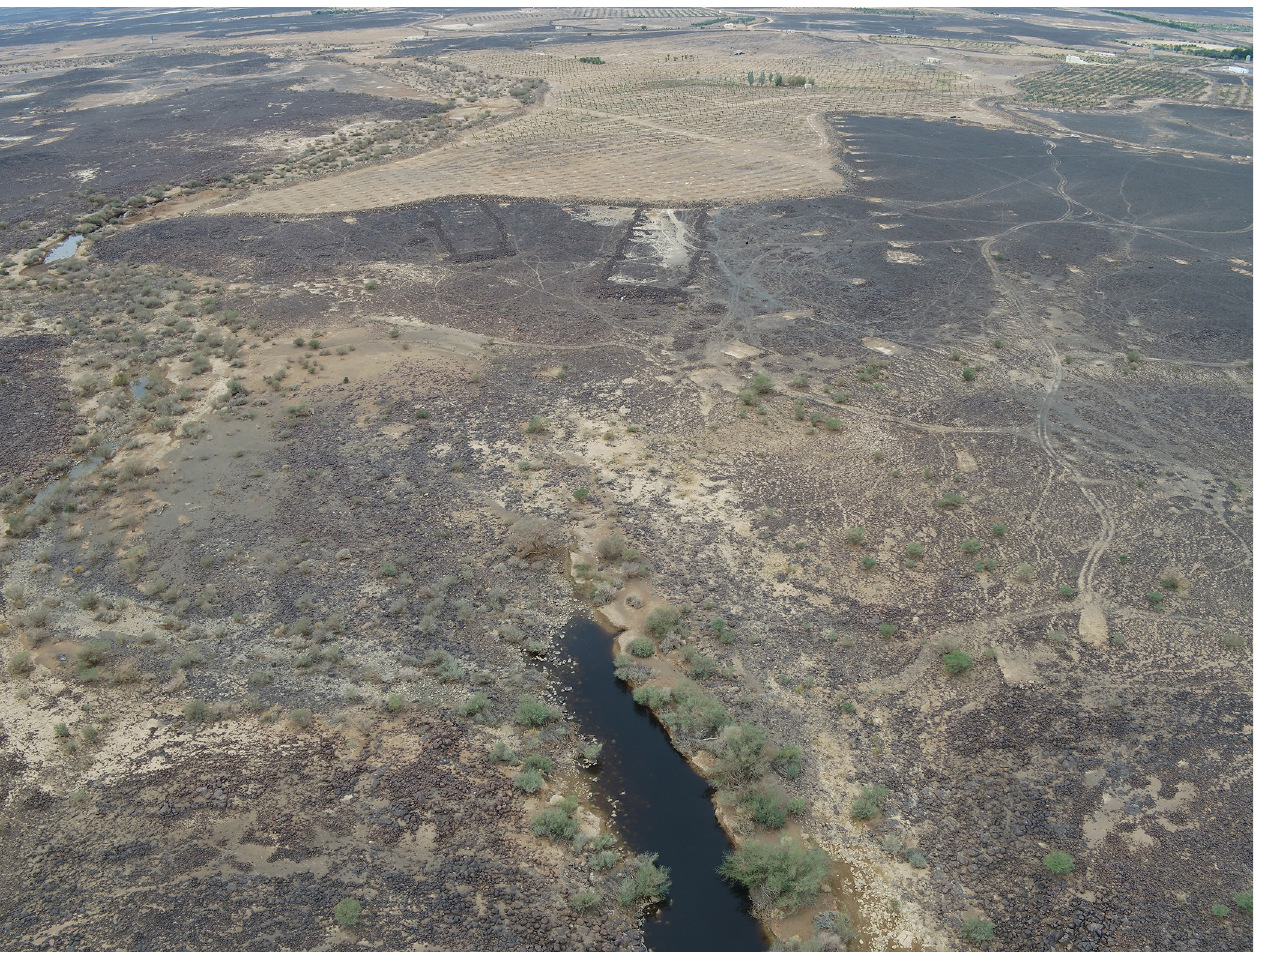
Fig 26. Two mustatil at site IDIHA-0030862 in Khaybar County orientated (base) towards a body of standing water, photo orientated